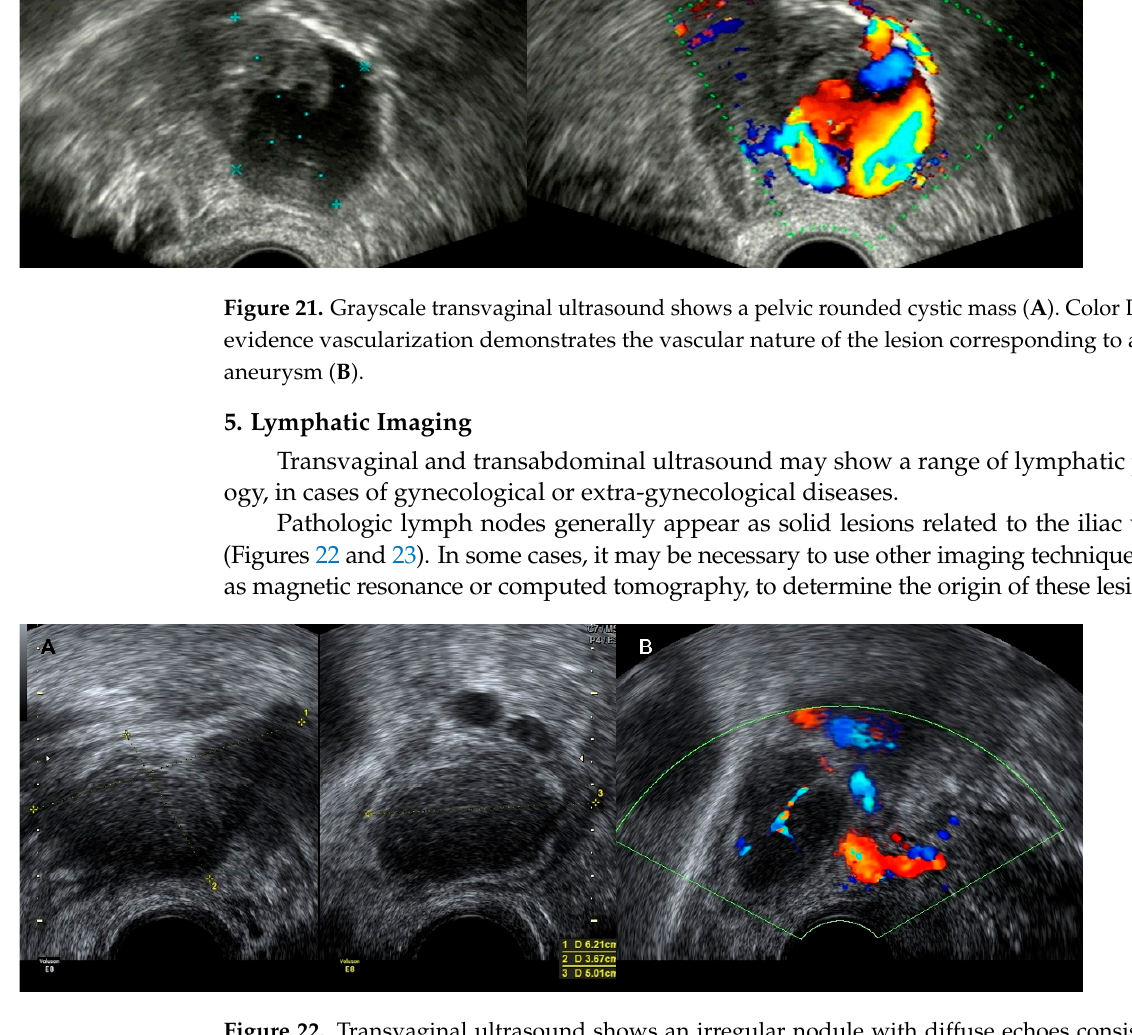
Figure 22. Transvaginal ultrasound shows an irregular nodule with diffuse echoes consisting of lymphoma ( A ). Color Doppler demonstrates central vascularization ( B ).